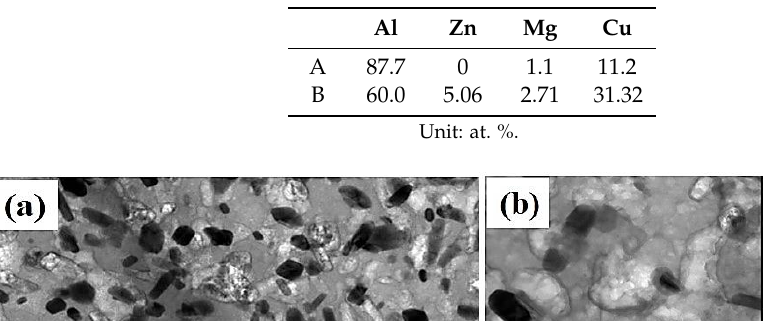
Figure 7. The morphology and the distribution of second phase particles for various HTA specimens: ( a ) HTA240-8; ( b ) HTA280-6; ( c ) HTA280-12; ( d ) HTA280-18; ( e ) HTA240-8 (high magnification); ( f ) HTA280-18 (high magnification). Table 4. EDS data for specimens shown in Figure 7e,f.